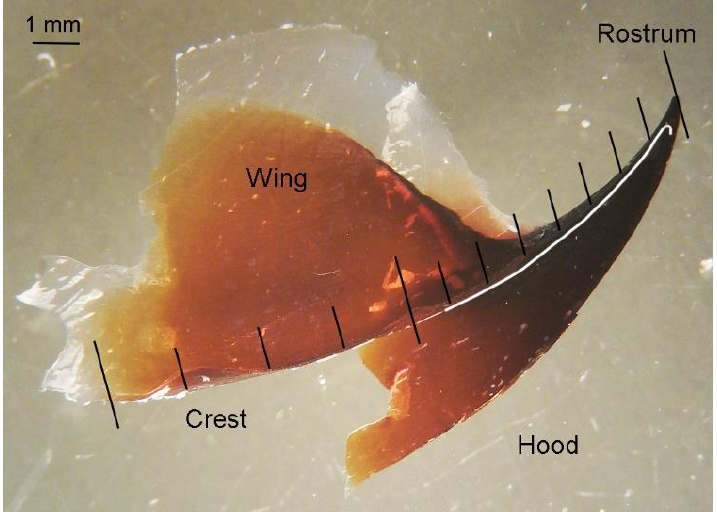
Figure 2. Scheme of the upper beak subsections cut in Gonatus fabricii from inside the crest: subsec- tions from the rostrum to the mid-point of the crest = 1 mm, and subsections from the mid-point of the crest to the transparent part of the hood = 2 mm. Upper beak = individual M1 with mantle length 216 mm. The white line shows the crest outline from the inside.